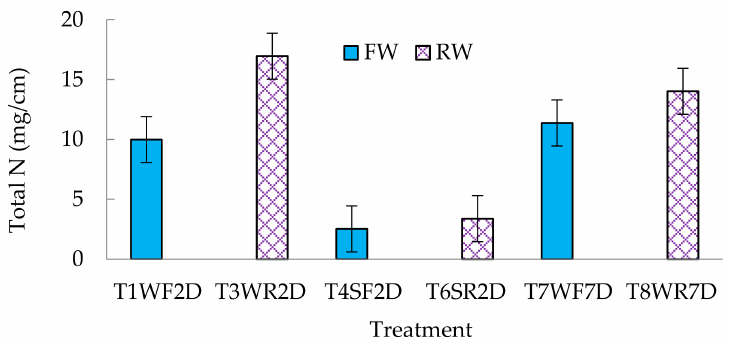
Figure 8. Total nitrogen (TN) in soil under six treatments and two different water qualities. Error bars indicate standard error. FW = fresh water, RW = recycled water. See Table 2 for treatment